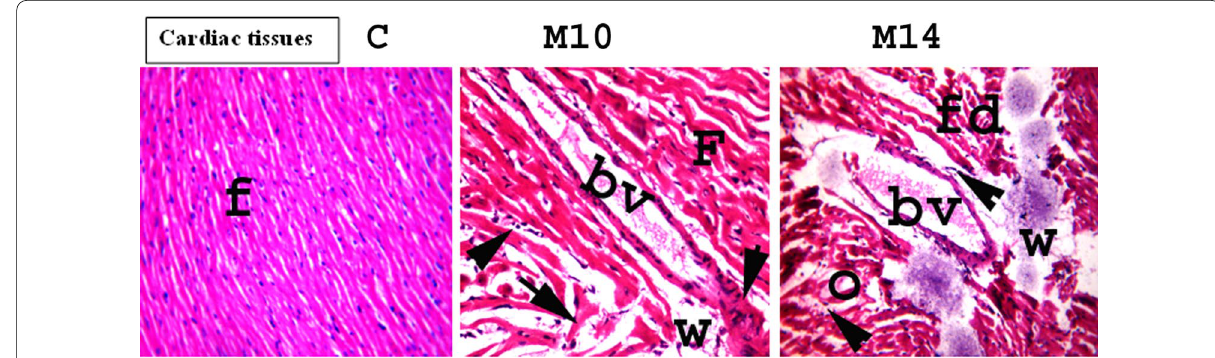
Fig. 1 A photomicrograph of cardiac section. (C) Control group; (M10) monosodium glutamate treated mice for 10 days and (M14) monosodium glutamate treated mice for 14 days. Cardiac muscular fibers (f); congested dilated blood vessels (bv); edema (o) and aggregation of inflammatory cells (arrow head); degenerated cardiac muscular fibers (fd); degenerated splitting fragmentation cardiac muscular fibers (arrow). H